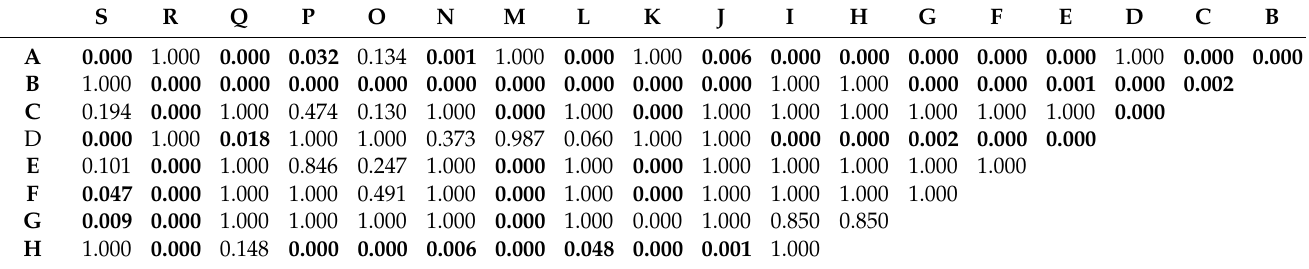
Table 3. P values for Dunnett’s multiple comparison tests for C. cinereus densities in sampling events ( p values lower than 0.05 denote significant differences, in